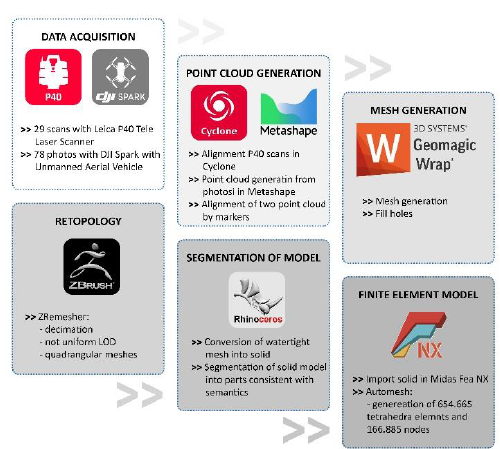
Figure 10. The workflow from Point cloud to FEA It is here reported for the shape of completeness of the reader. It was carried out cutting off the solid through the Table 4 Comparison between experimental and numerical data considering the numerical model updated to the last step 1. RESULTS AND DISCUSSION